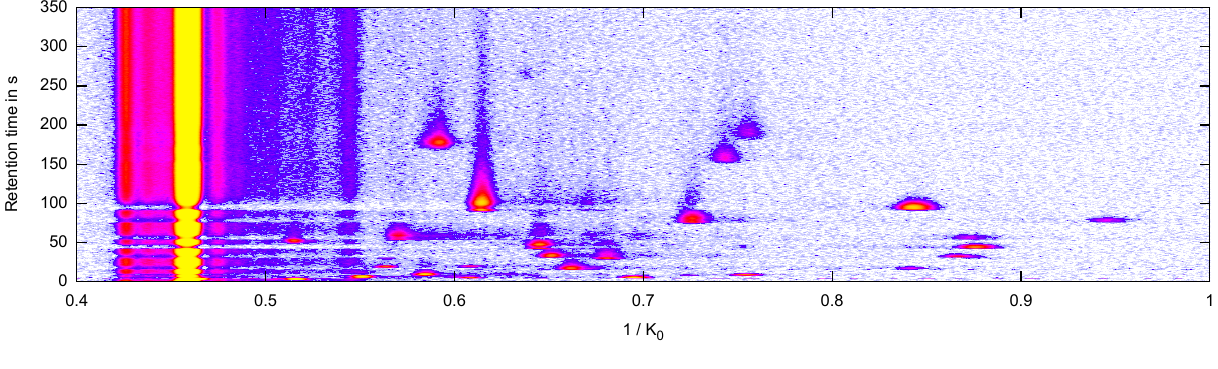
Figure 1. Heat map of an MCC/IMS measurement. X-axis: inverse reduced mobility 1 /K in Vs / cm 2 ; Y-axis: retention time r in seconds; signal: white (lowest) < blue < purple < red < yellow (highest), reaction ion peak (RIP) at 1 /K